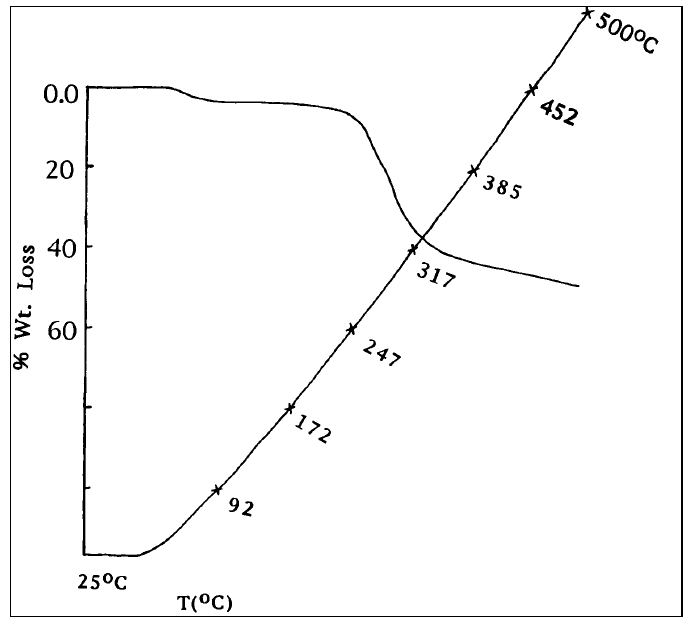
Figure 7 Thermogram of PANi/H as used in Figure 5.